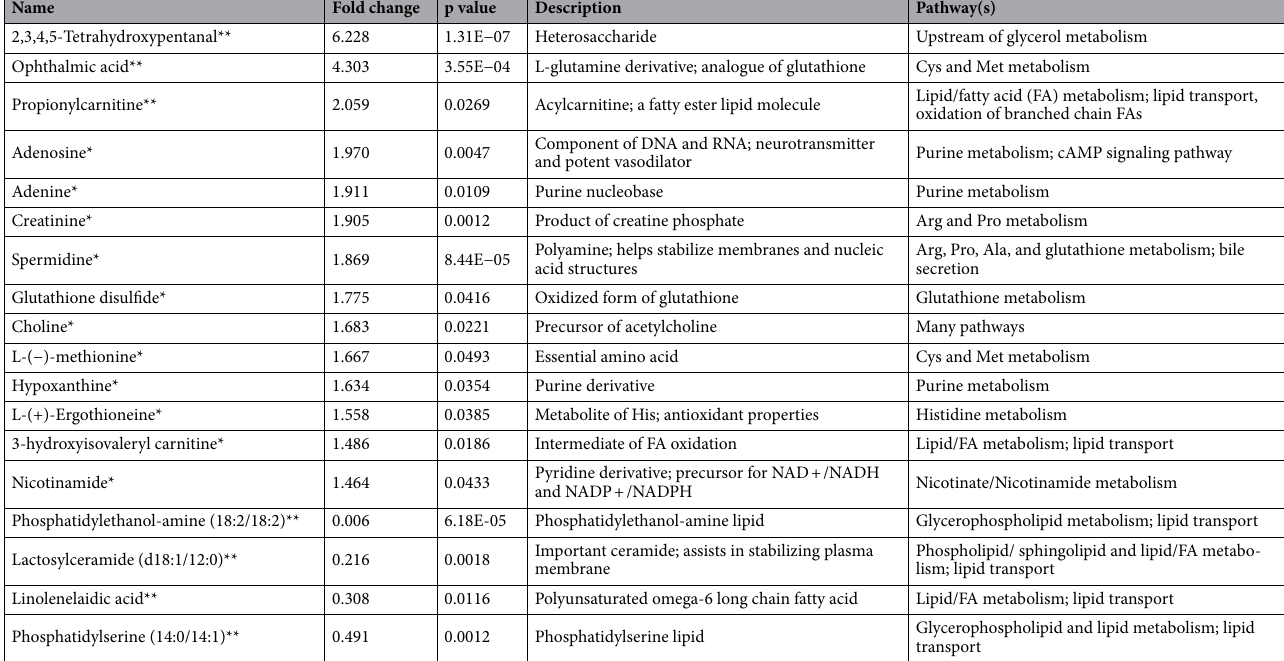
Table 1. Significant results from the untargeted metabolomic screen of liver from female Dex exposed offspring compared to their saline controls. Compounds identified as ** indicate metabolites that reached the two cut-off criteria (p < 0.05 and fold change > 2 or < 0.5) while compounds identifed as * indicate metabolites that reach the p < 0.05 criteria only. Upregulations are presented first in descending order with downregulations following (n =